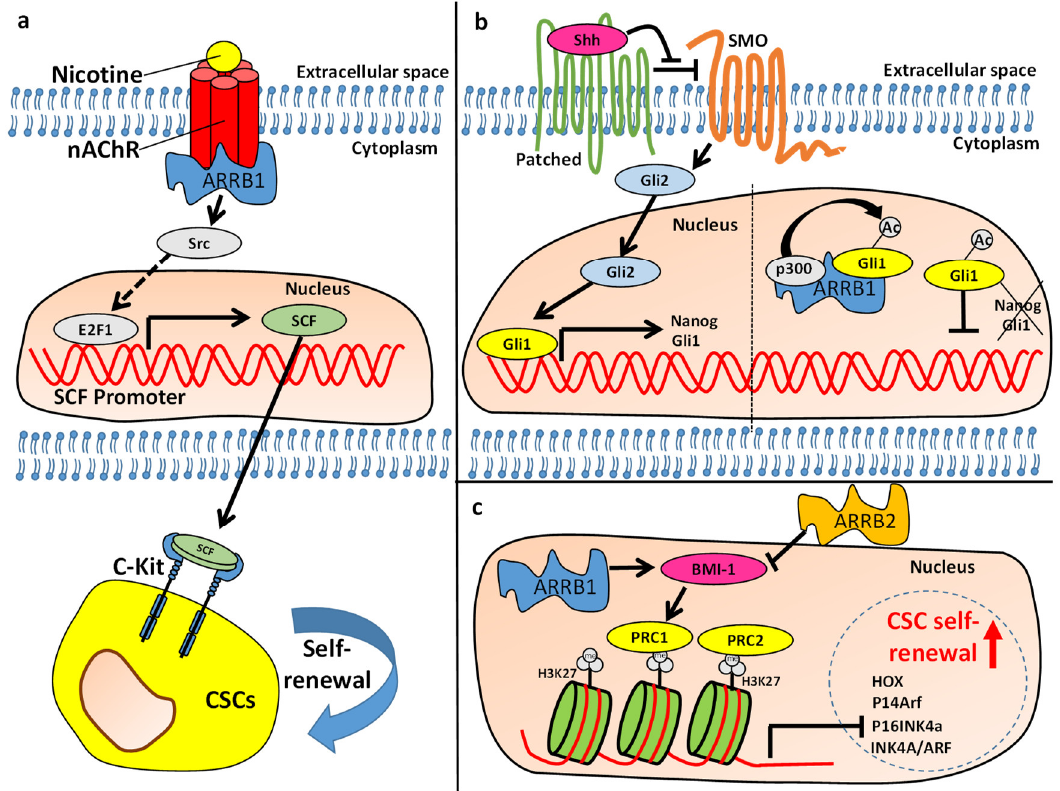
Figure 2. The role of β-arrestins (ARRBs) in regulating self-renewal in solid cancers. ( a ) ARRB1 plays a crucial role in nicotine mediated effects in non-small cell lung cancers (NSCLCs). Binding of nicotine to nicotinic acetylcholine receptors (nAChRs) results in activation of Src in an ARRB1-depended fashion. Src activates the transcription factor E2F1, which drives expression of stem cell factor (SCF) in NSCLC cells. Once SCF is secreted, it can bind c-Kit receptors on cancer stem cells (CSCs) and induce self-renewal. ( b ) When Patched is in a ligand-unbound state, it represses Smoothened (Smo). Binding of Sonic hedgehog (Shh) to Patched results in activation of Smo, which activates transcription factors Gli2/3. The later drive expression of Gli1, which drives expression of genes that regulate self-renewal. ARRB1 promotes the p300-mediated acetylation of Gli1 inhibiting its transcriptional activity and thus expression of genes involved in self-renewal in Shh-medulloblastoma. ( c ) ARRB1 and ARRB2 have opposing effects on Bmi-1 in bladder cancer. ARRB1 positively regulates Bmi-1, a component of the polycomb regulatory complex 1 (PRC1). PRC1 and PRC2 cooperate by binding to trimethylated lysine residues of H3 (H3K27), causing changes in chromatin structure and transcriptional silencing of genes regulating CSC differentiation (e.g., Hox) and self-renewal (Ink4a/Arf) [50,51]. ARRB2 inhibits Bmi-1 mediated self-renewal.